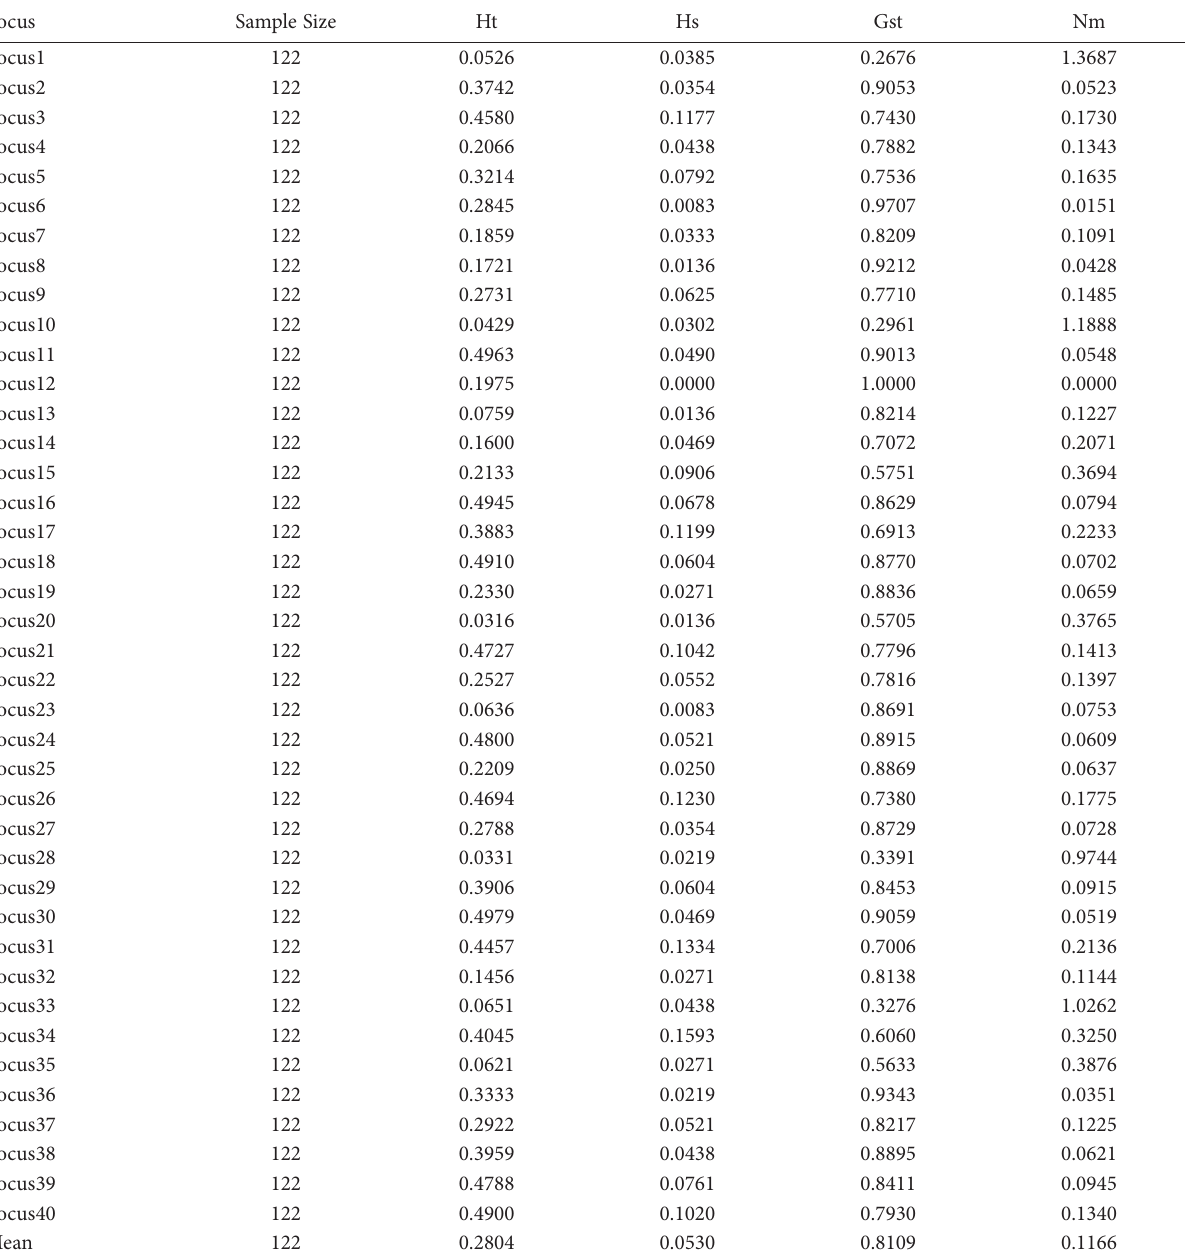
Table S2. Discrimination power (Gst value), of SSR loci obtained. Locus Sample